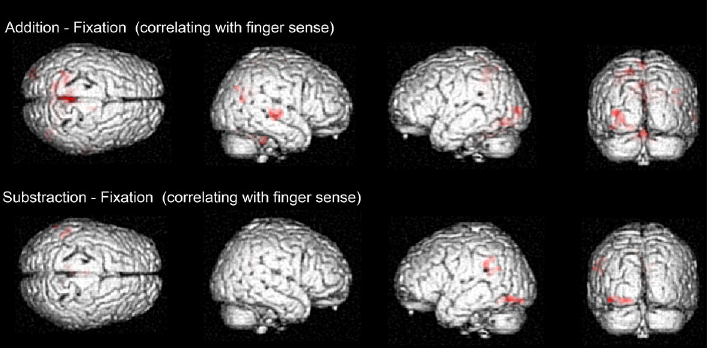
Figure 2. Regions that show activation correlating with finger gnosis scores for addition and subtraction.